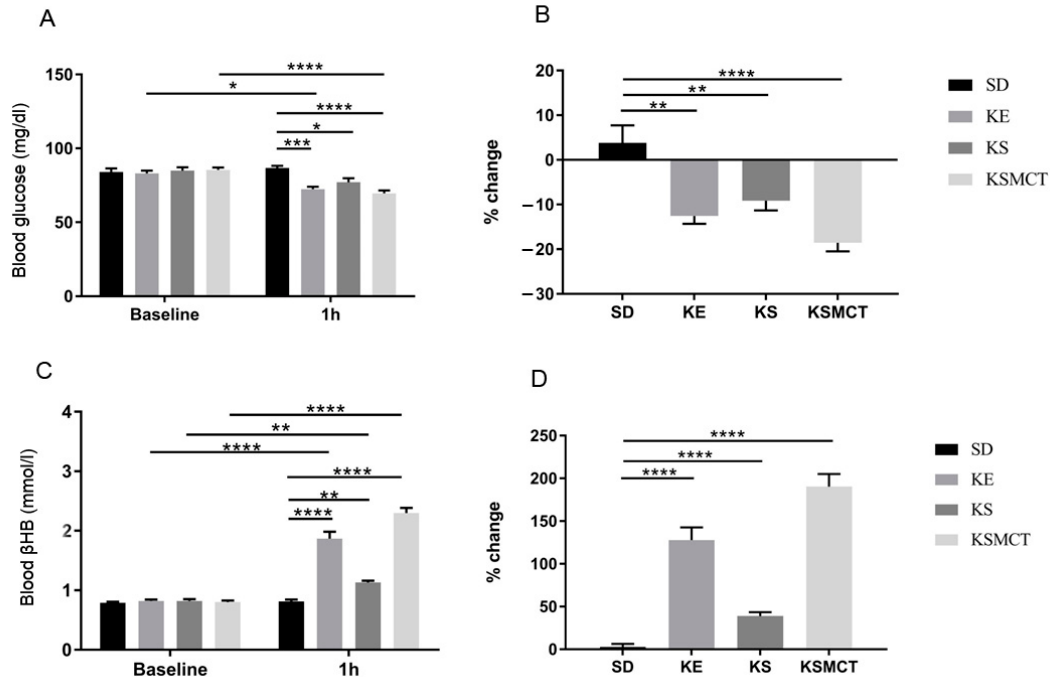
Figure 4. Changes in blood glucose and R - β HB levels of 6-months-old WR rats after 1 h of treatment, in rested state. ( A ) The change in glucose levels in WR rats, with no exercise, for the baseline and 1 h post-treatment. ( B ) The corresponding percent change in glucose levels. ( C ) The resulting blood R - β HB levels. ( D ) The percent change in the blood R - β HB levels. Abbreviations: WR: WAG/Rij rat; SD: